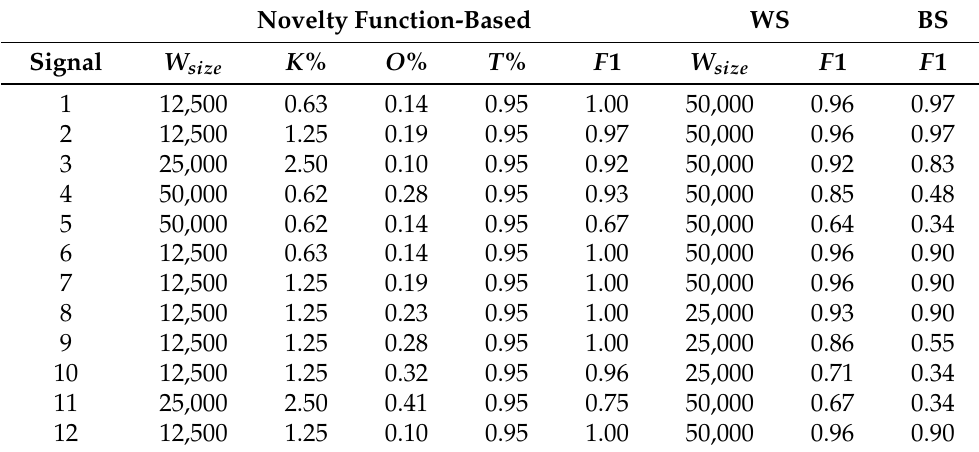
Table A4. Parameter configuration and experimental results of each signal in Dataset 3 (ECG2, see Section 3.3). W size : window size; K %: kernel size in percentage of the window size; O %: overlap percentage of the window size. T %: amplitude threshold for event detection; WS: window-based segmentation; BS: binary segmentation. The tolerance used to calculate the F1-score ( F 1) equals the window size for novelty function computation. Novelty Function-Based Signal